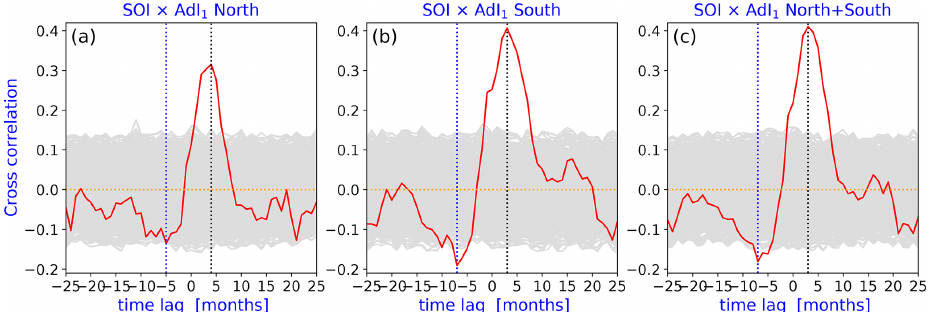
Figure 5. Cross-correlation between SOI and the monthly advection index AdI 1 for the northern and southern subsets of advected parcels (red). Dashed blue/black line indicates the time lag at which the cross-correlation is at its absolute minimum/maximum. The gray band indicates the 99% confidence interval, as described in Sect. 2. (a) AdI 1 for the northern subset (see Fig. 2a). (b) AdI 1 for the southern subset (see Fig. 2b). (c) Cross-correlation between SOI and the joint monthly advection index AdI 1 for all the westward-moving parcels. The strongest correlation occurs at + 3 months in each case, meaning that the advection strength AdI 1 leads SOI: a strengthening of advection is followed by an increasing pressure anomaly (above-normal air pressure at Tahiti and below-normal air pressure at Darwin, Australia) with a delay of 3 months, and vice